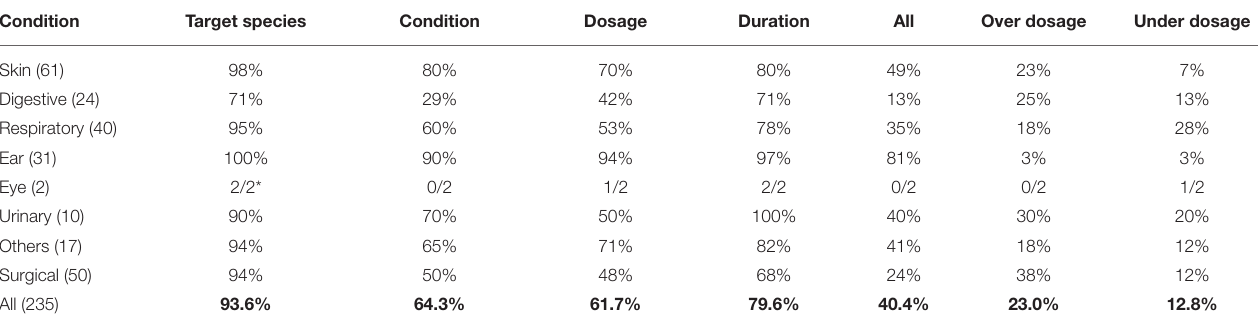
TABLE 6 | Assessment of compliance with the summary of the product characteristics (SPC) of 235 veterinary medicinal products (VMP) prescribed to 300 dogs.